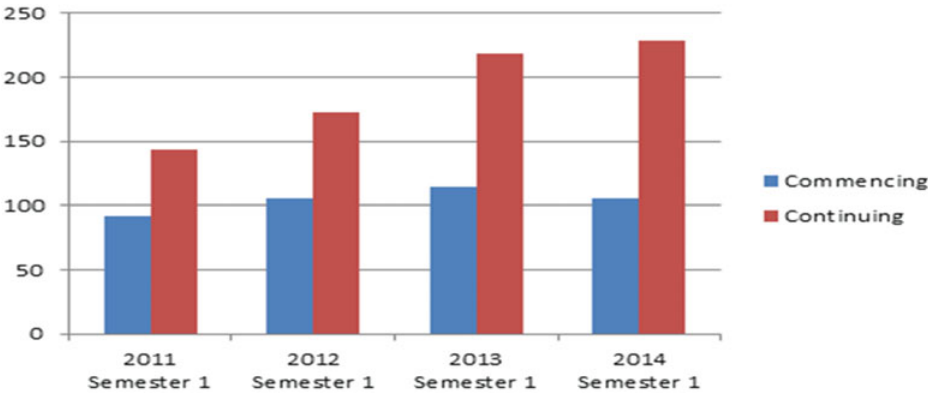
Figure 1. (Colour online) Indigenous student commencing numbers relative to continuing indigenous numbers at UNSW.